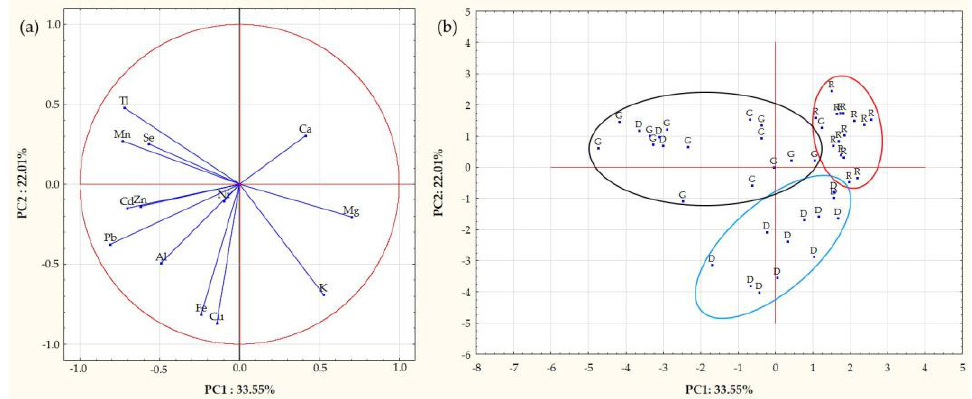
Figure 1. Principal component analysis (PCA) results combining the first two principal components (PC1 and PC2); variable loadings ( a ) and plant individual scores ( b ); R—rapeseed, D—dandelion, G—goldenrod.